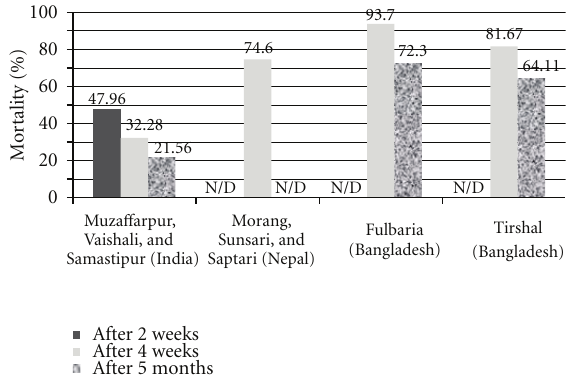
Figure 4: Findings of output indicator: bioassay test on IRS surfaces and bioassay results from Baijanathpur-8 and Sundarpur-3 after two weeks of spraying and from Baijanathpur-8 after four weeks of spraying were not included due to high mortality in control tests.